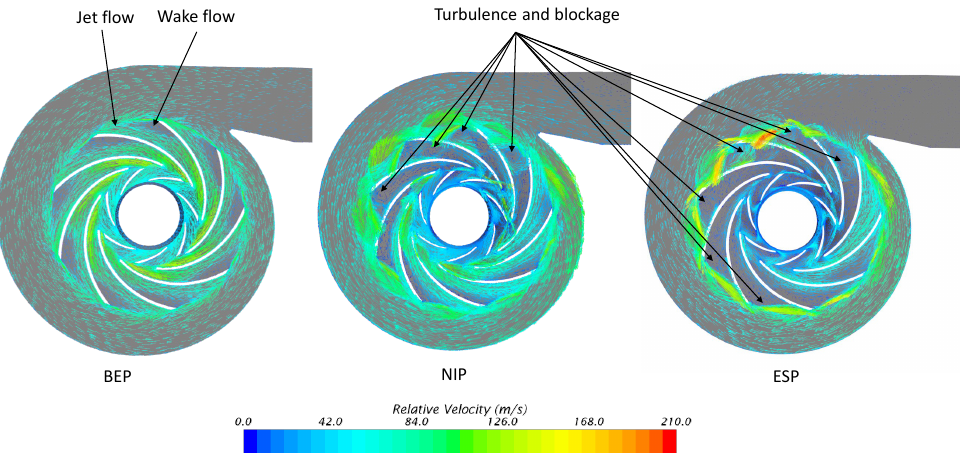
Figure 9. Relative velocity vector distribution on 0.5 span